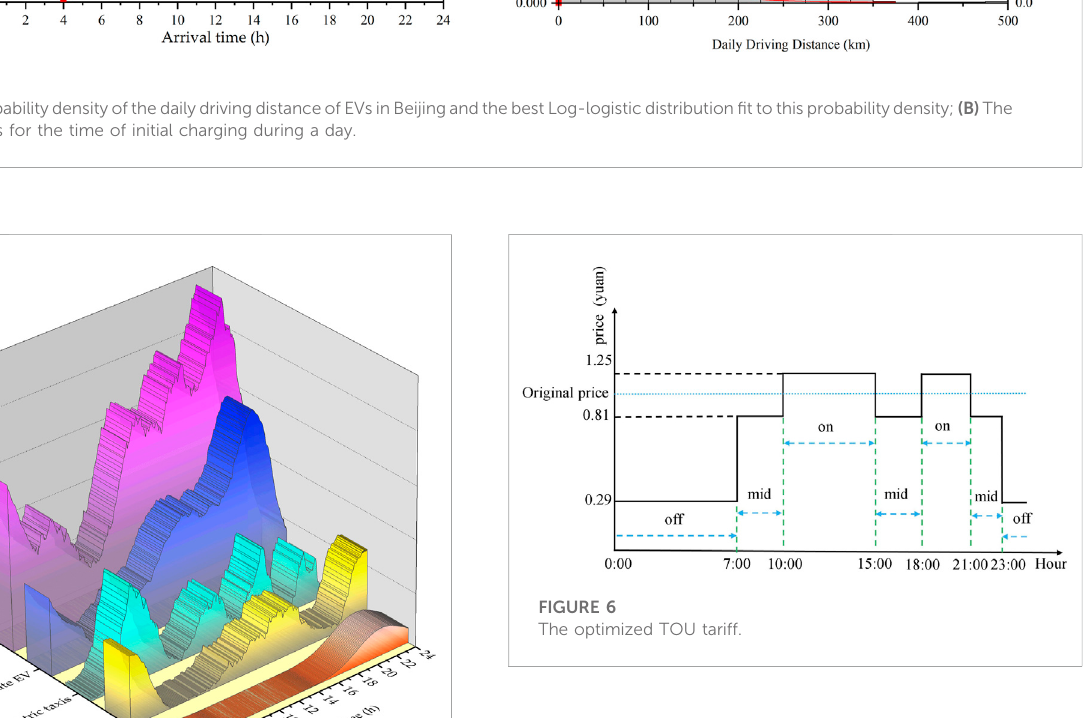
FIGURE 5 The total power consumption over a day by four types of EV on a typical weekday in